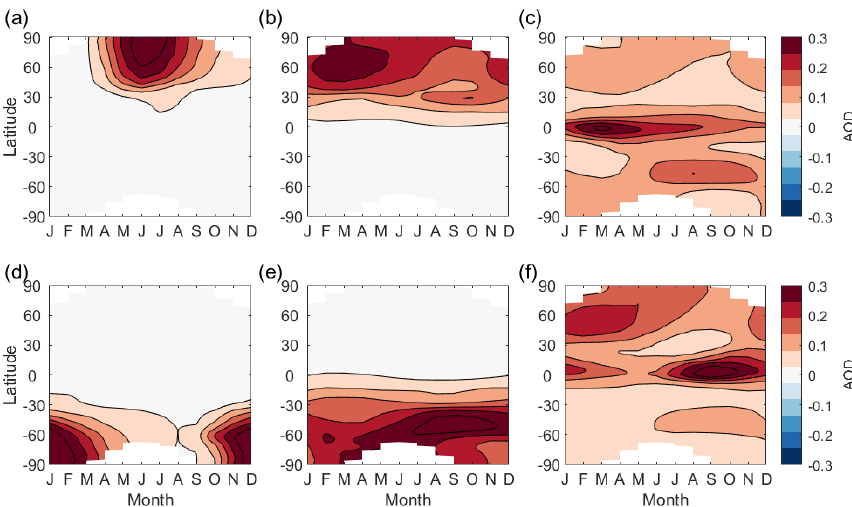
Figure 14. AOD patterns from the best set of six injections: (a) spring injection at 60 ◦ N, (b) annual injection at 30 ◦ N, (c) winter injection at 0 ◦ , (d) spring injection at 60 ◦ S, (e) annual injection at 30 ◦ S, and (f) summer injection at 0 ◦ .